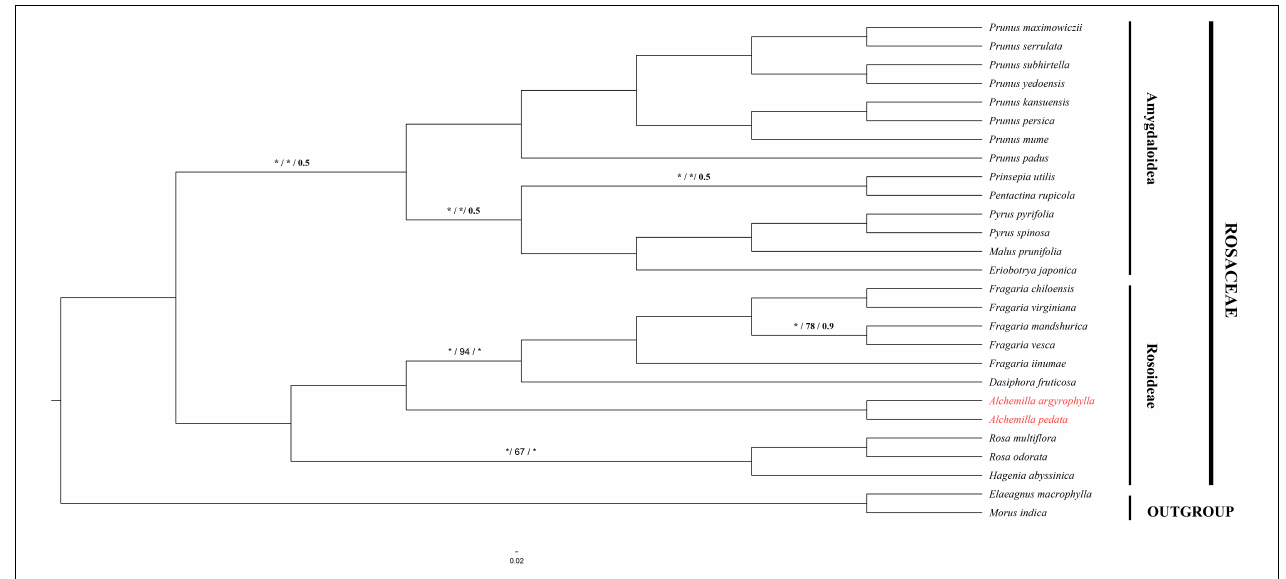
FIGURE 6 | Phylogenetic tree reconstruction based on maximum-likelihood IQ-Tree in PhyloSuite (Zhang et al., 2020) with 1,000 replications, PhyML (Lefort et al., 2017) and BI based on MrBayers (Ronquist et al., 2012) in 200,000 generation using 78 protein-coding genes common in 27 Rosaceae species. The numbers above the branch represent bootstrap support value for ML/PhyML/BI methods, where the asterisk signifies maximum support value of 100 in IQ and 1 BI. Blank branches signify 100% support